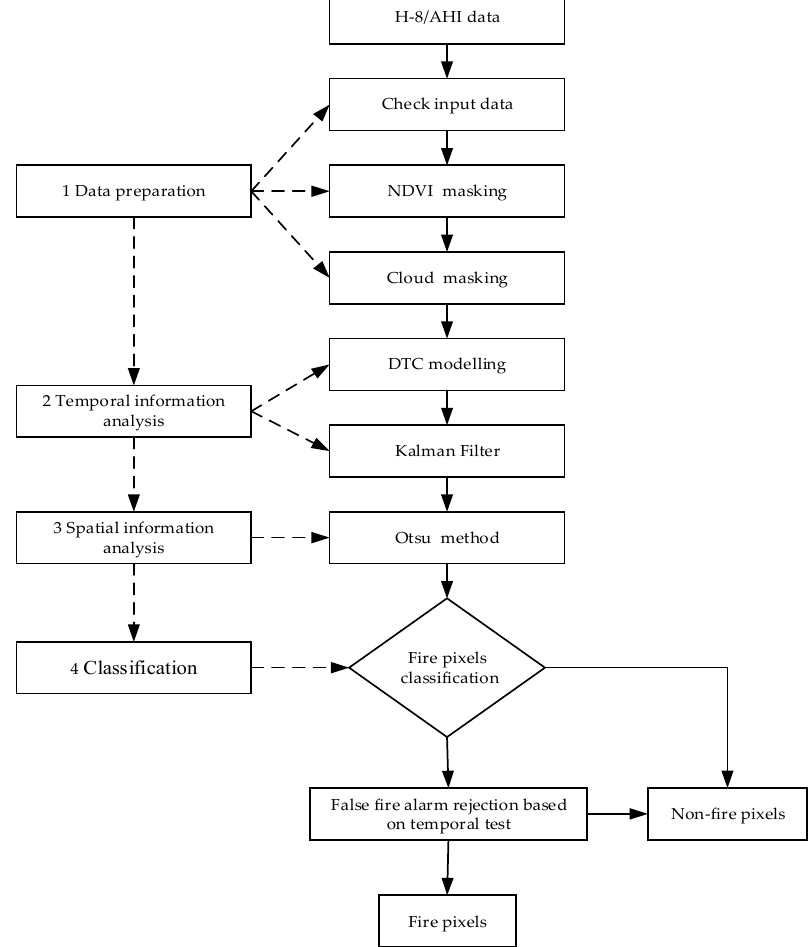
Figure 2. Flowchart of the STCM forest fire detection based on H-8/AHI data.